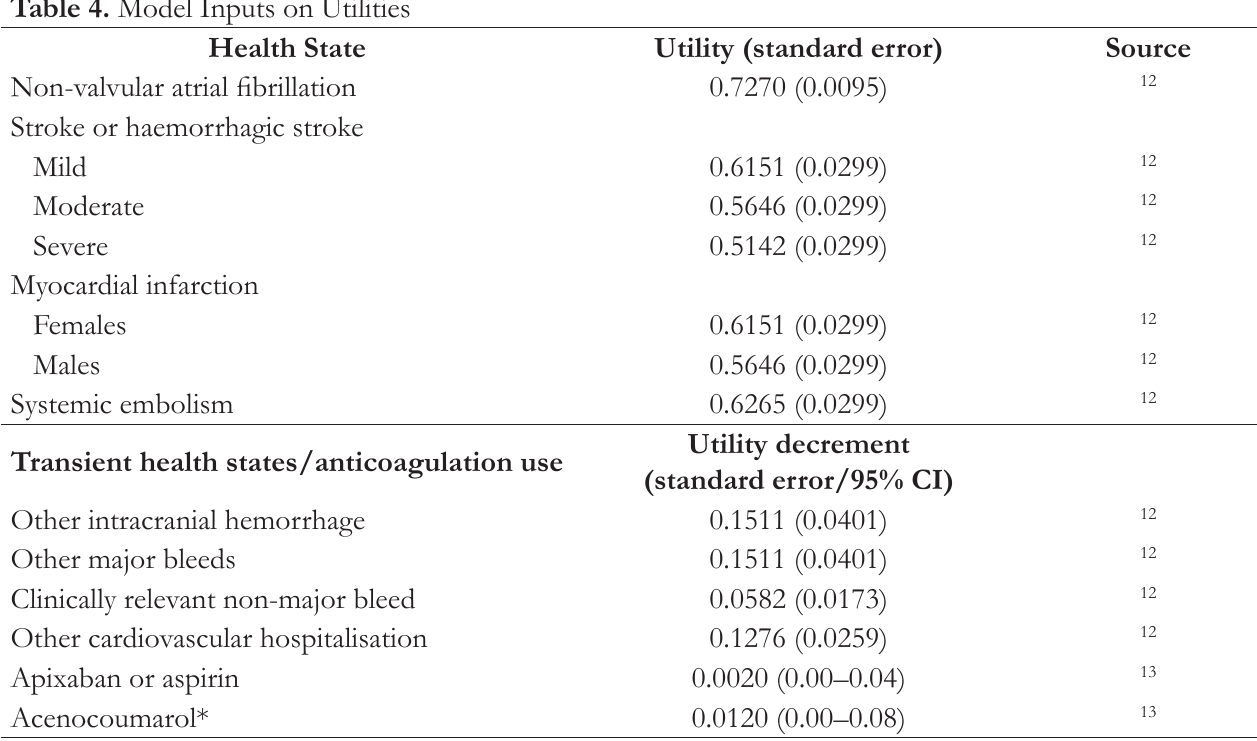
Table 4. Model Inputs on